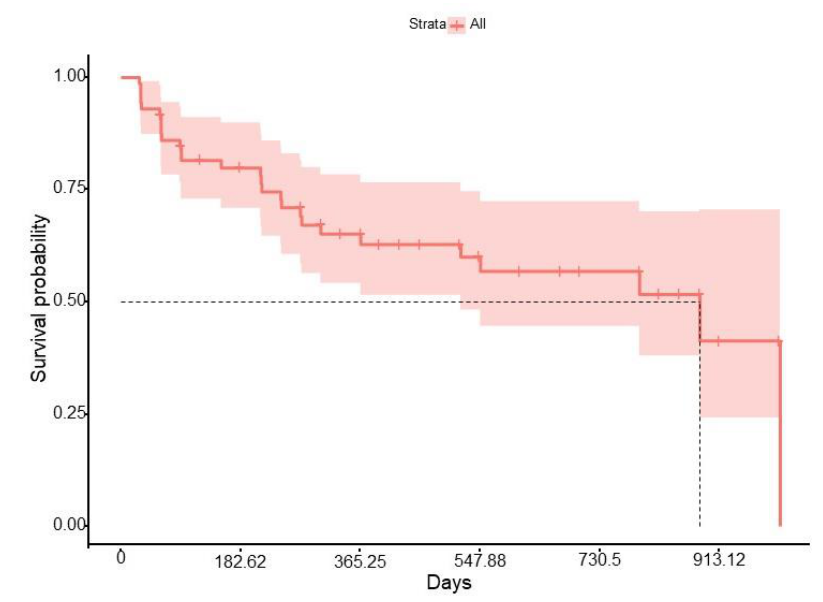
Figure 1. Ixekizumab survival curve.